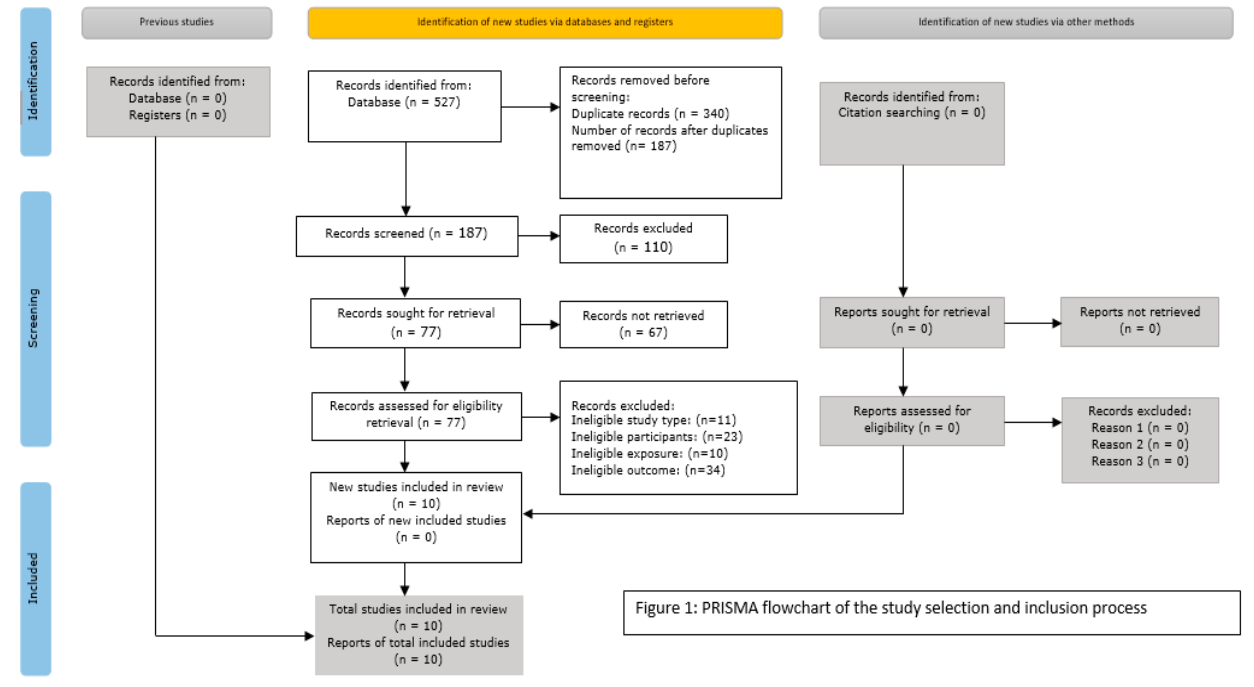
Figure 1. PRISMA Figure 1. PRISMA TABLE.